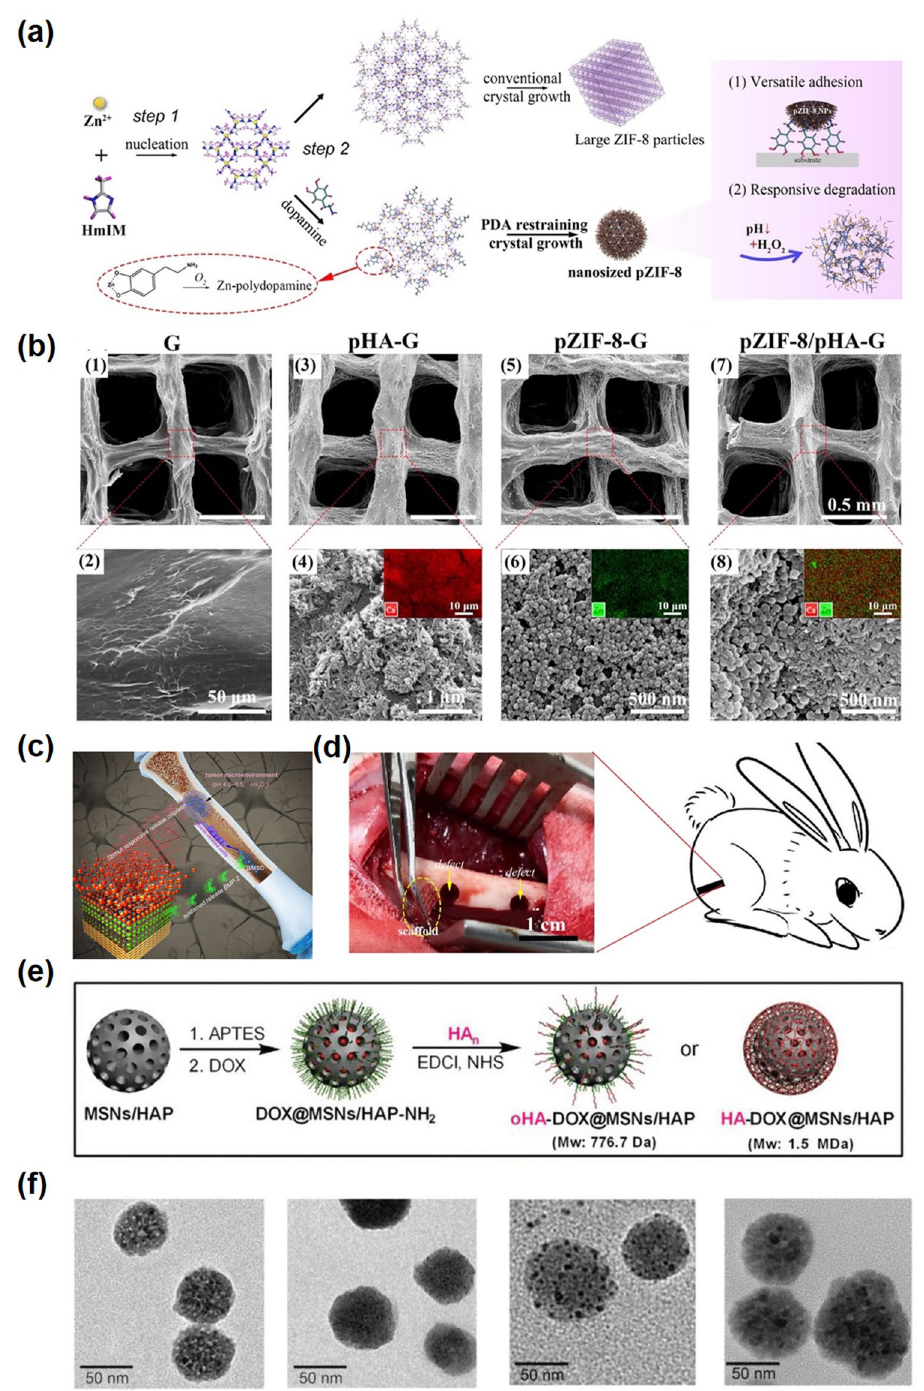
Fig. 6 Hydroxyapatite-based nanomaterials. a Scheme of the fabrication process of polydopamine-hybrid ZIF-8 nano-MOF. b Microstructure of different bone-filled scaffolds. The photographs inserted in (4), (6), and (8) are the EDS images. c The scaffold had the dual function of antitu- mor and bone regeneration, which can release cisplatin and BMP-2 in acidic TME to inhibit tumor growth and continuously achieve bone regen- eration. d Scaffold implantation of femur condyle defect model in the rabbit [86]. Copyright 2021, Elsevier. e Synthetic process of oHA-DOX@ MSNs/HAP NPs or HA-DOX@MSNs/HAP NPs. f TEM images of MSNs/HAP NPs, DOX@MSNs/HAP NPs, oHA-DOX@MSNs/HAP NPs, and HA-DOX@MSNs/HAP NPs, respectively [87]. Copyright 2019,